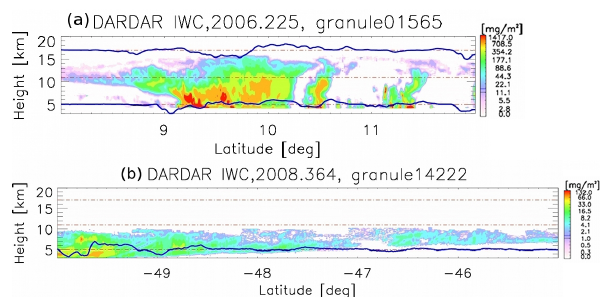
Figure 2. IWC curtains (color shading) from DARDAR-Cloud v2.1.1 retrieval products for the two cases shown in Fig. 1. Color scale is linear, and ranges between the maximum DARDAR IWC value within the curtain (red) and 0 (white). One can only find sub- tle differences in the IWC and (cid:49) IWC (blue solid lines) values, but the clouds are in general more ubiquitous in the DARDAR product. For example, the DARDAR ice cloud product reveals a thin cirrus layer above the anvil clouds in the tropical deep convection case that is not detected by